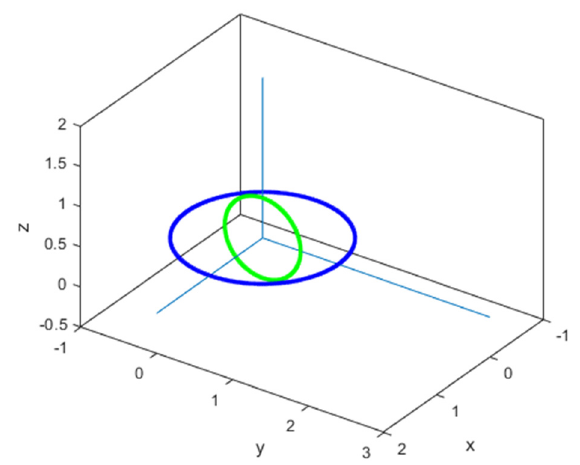
Figure 7. Case (c): two perpendicular circular loops. Not a singular case, ( a = 1, b = c = 0, L = l = 1). (c) C (0 m ; 0 m ; 0 m )